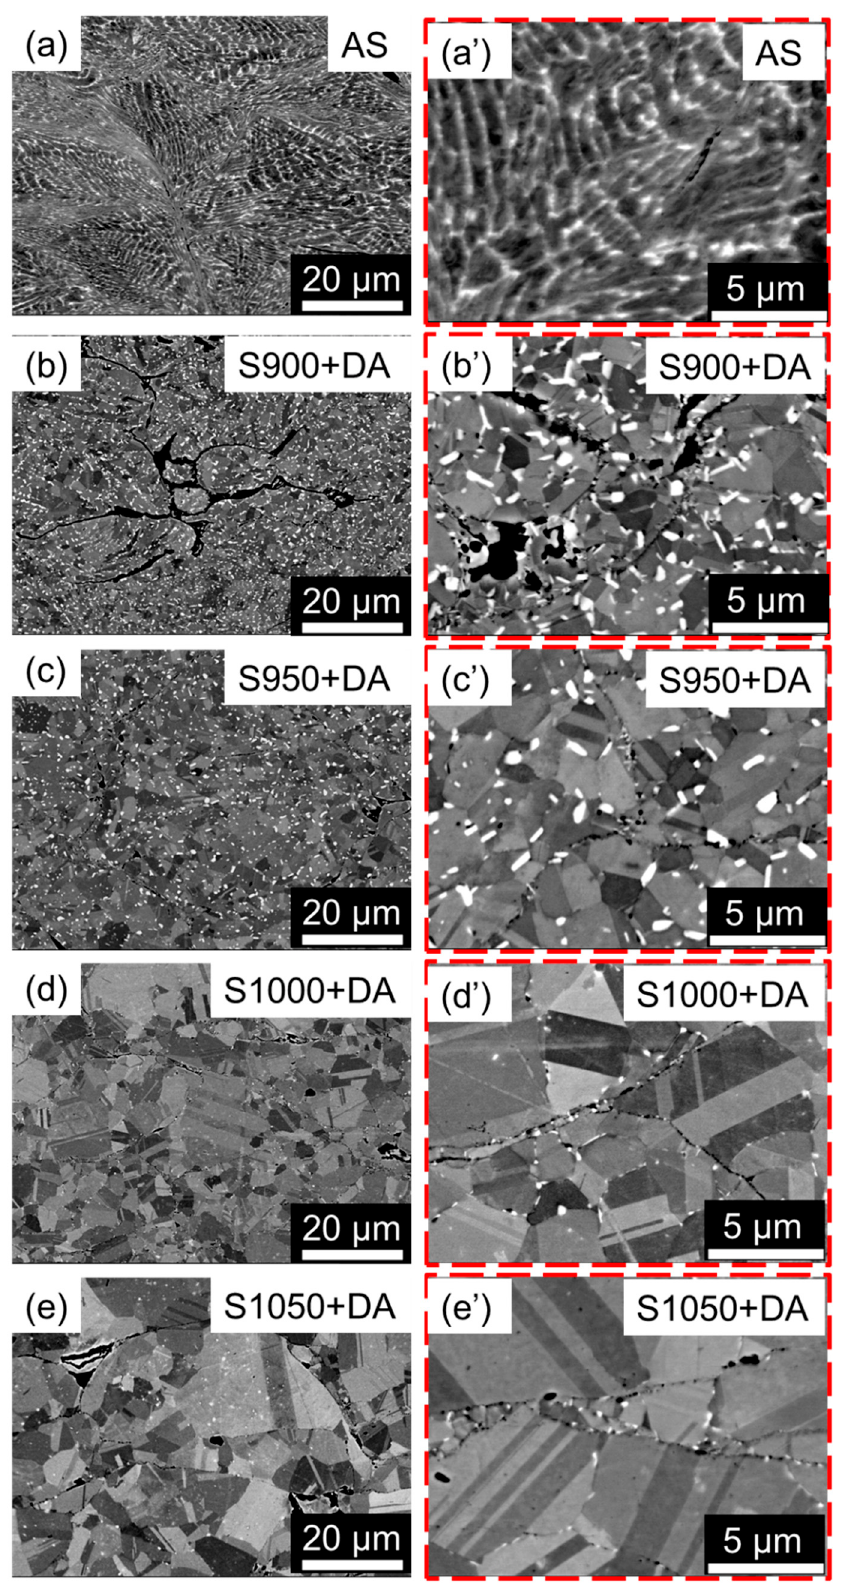
Figure 6. BSE-SEM micrographs of cold sprayed IN718 coatings under different conditions: ( a , a’ ) as-sprayed, ( b , b’ ) 900 °C solution + double aging, ( c , c’ ) 950 °C solution + double aging, ( d , d’ ) 1000 °C solution + double aging, and ( e , e’ ) 1050 °C solution + double aging.